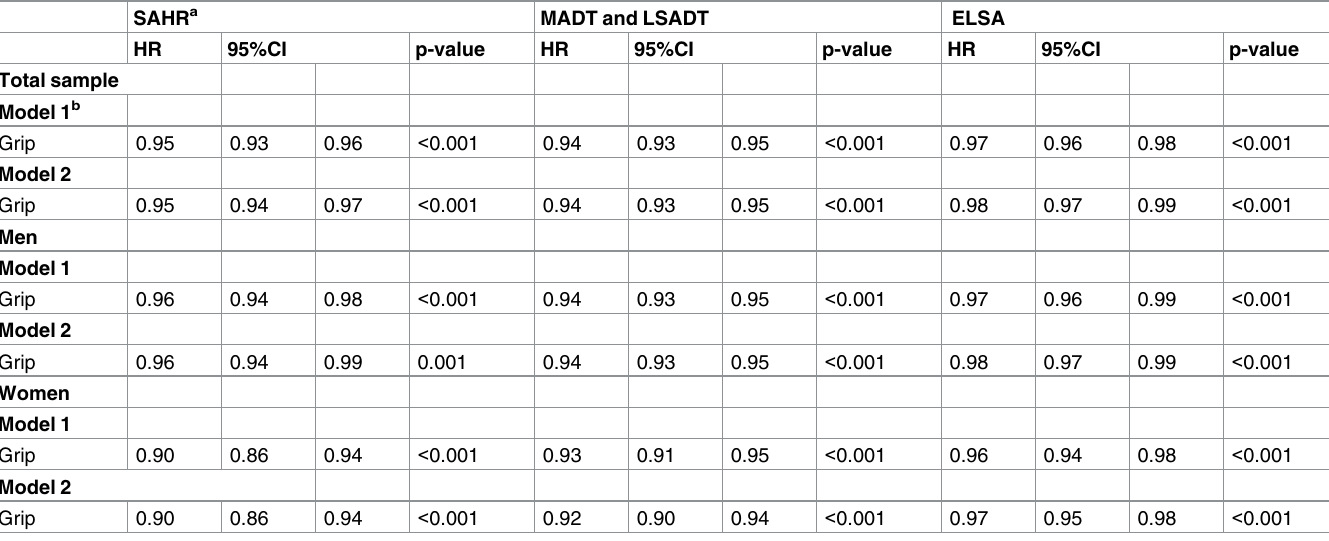
cross-country differences in muscle strength. The study participants in Moscow had lower grip strength than their counterparts in most of the countries included in the Survey of Health, Table 3. Mortality per 1-kg increasein grip strength in Moscow, Denmark, and England. SAHR a MADT and LSADT ELSA HR